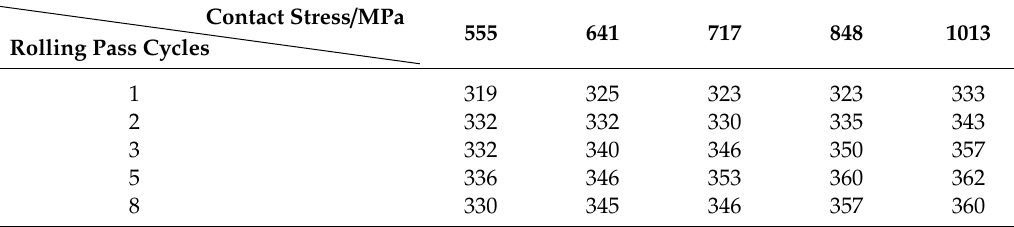
Table 3. Surface microhardness HV 0.2 .